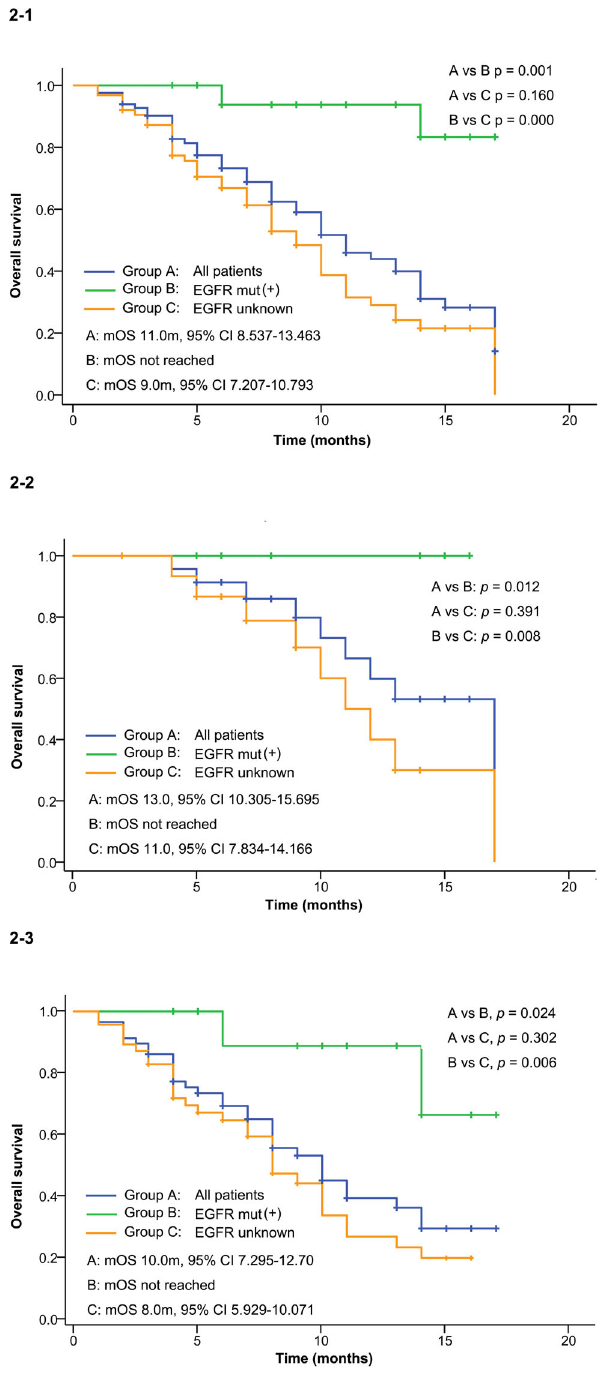
Figure 2. Overall survival. 2–1 shows the OS in all patients in this study, 2–2 shows the OS in first line subset, 2–3 shows the OS in second/third line subset. doi:10.1371/journal.pone.0095897.g002 while the OS for EGFR mutation patients was not reached. These results were similar with those reported in ICOGEN. In the ICOGEN study, patients with NSCLC that progressed after one or two lines of chemotherapies were randomized to receive group, the median PFS were 4.6 m for all patients and 7.8 m in